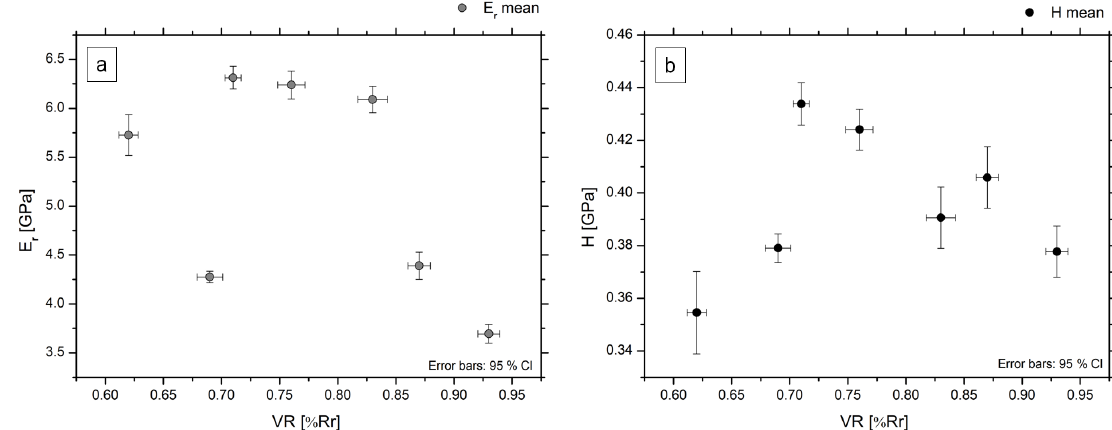
Figure 8. E r (a) and H (b) obtained for sporinites at varying maturity (0.62 to 0.93%Rr). (CI = Confidence interval).